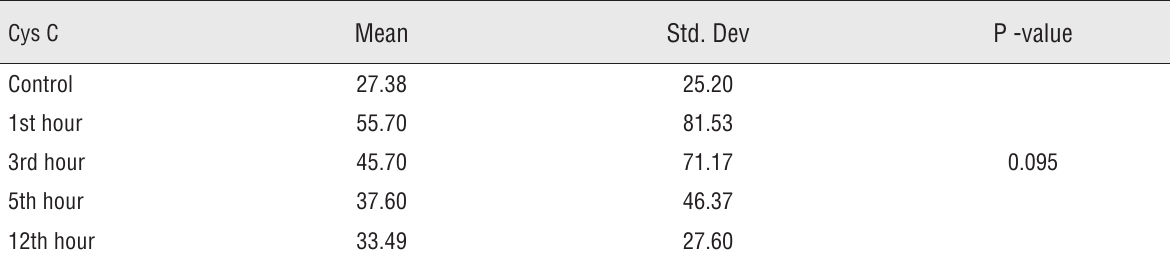
Table 4 - Variation in Cys-C (ng/mL) measured in urine. Cys